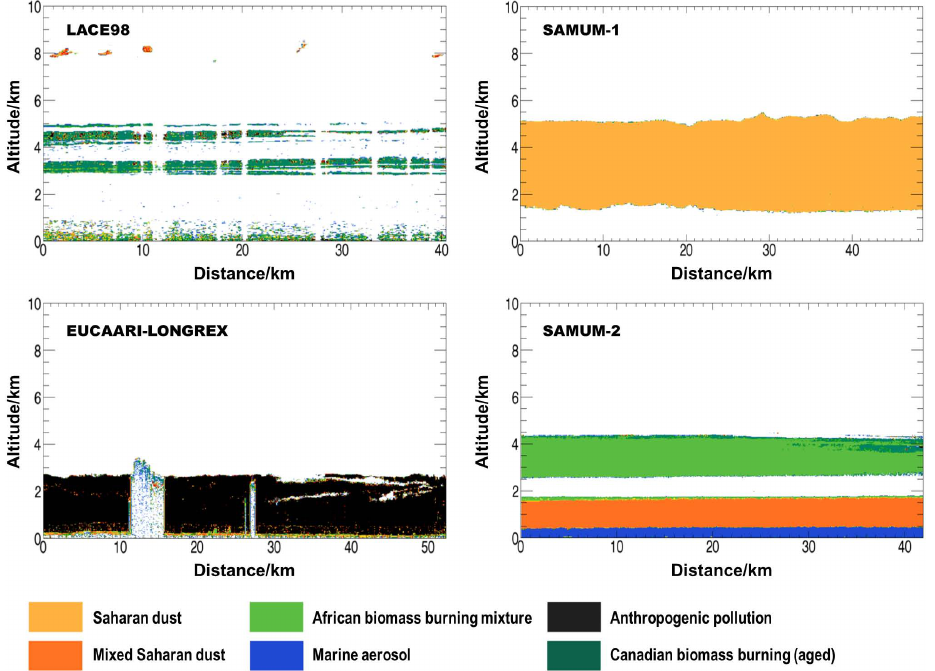
Fig. 9. Aerosol mask for the measurement examples shown in Fig. 4. The aerosol layers are color-coded corresponding to their aerosol type distinguished by intensive lidar optical properties. As the discrimination of the different aerosol types shown in this figure is based only on our own measurement results (Saharan dust, mixed Saharan dust, African biomass burning mixture, Canadian biomass burning aerosol, anthropogenic pollution, and marine aerosol) a classification for ice is missing; therefore the cirrus clouds in the LACE98 case are